Question: Write a single sentence explaining what this figure depicts.
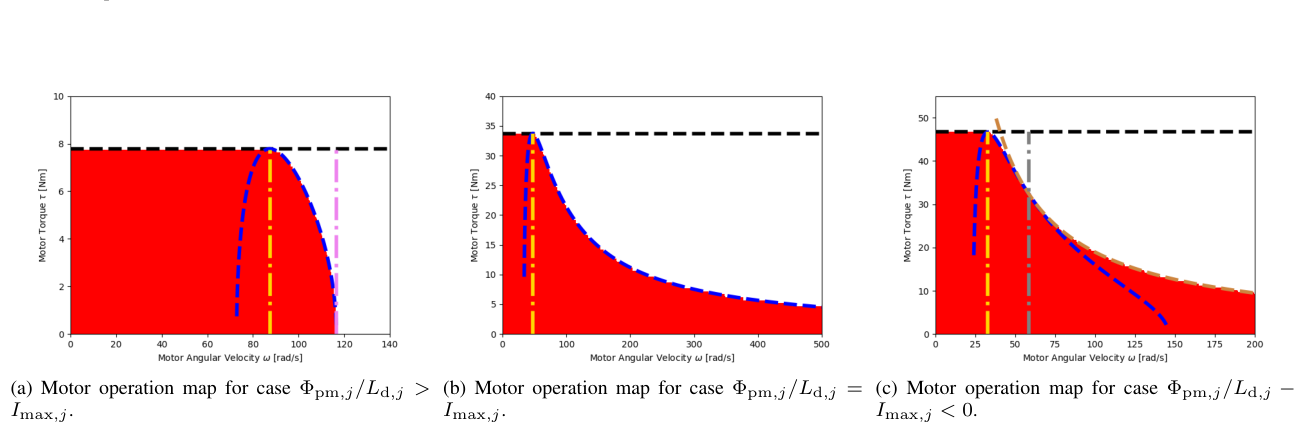
Answer: Motor operation map in all cases. The red region represents the feasible operation range; the white region represents the infeasible range. The meaning of the dashed and dash-dot lines/curves is given in Section IV-C.